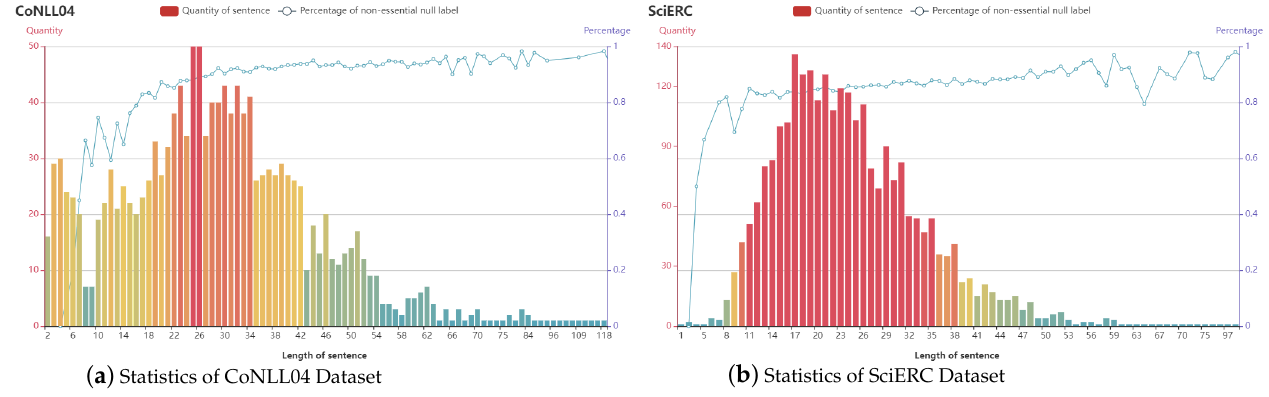
Figure 2. In the datasets CoNLL04 and SciERC, the percentage of non-essential null labels is positively correlated with the sentence length, and the percentage of non-essential null labels is above 80% for most of the